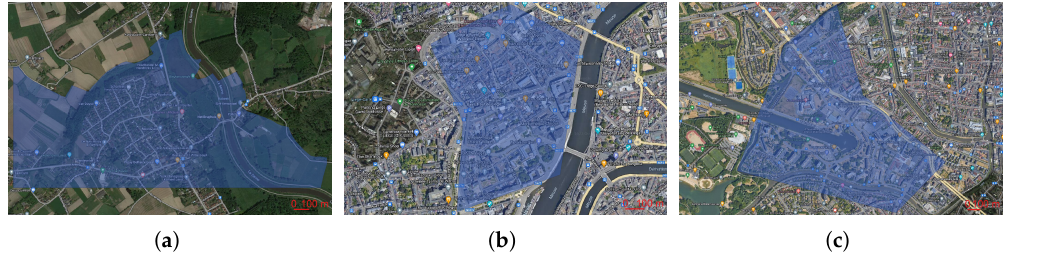
Figure 4. Use cases simulated areas of interest. ( a ) Leest—Rural. ( b ) Liege—Urban. ( c ) Ghent—Tall